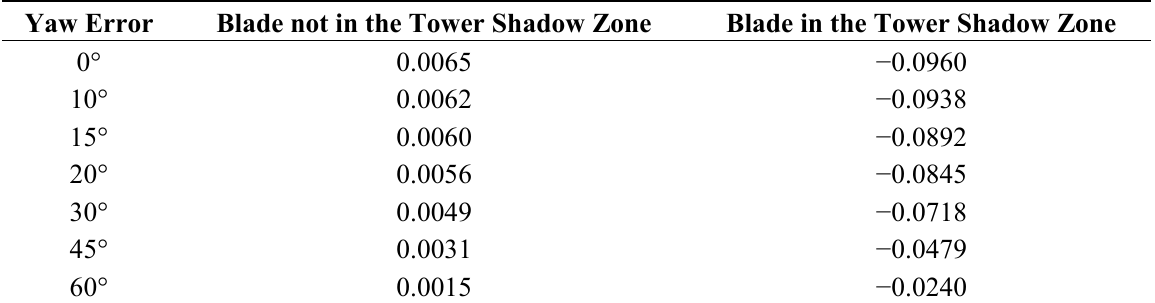
Figure 4. Variation in T c due to yaw error. Table 3. T c oscillation